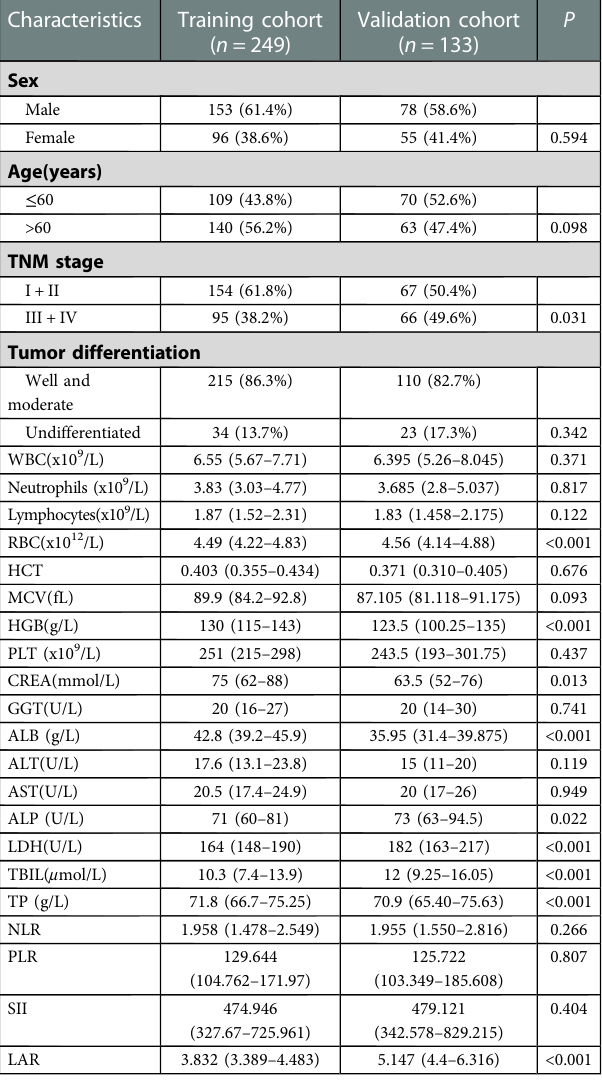
TABLE 1 Demographic and clinical characteristics of CRC